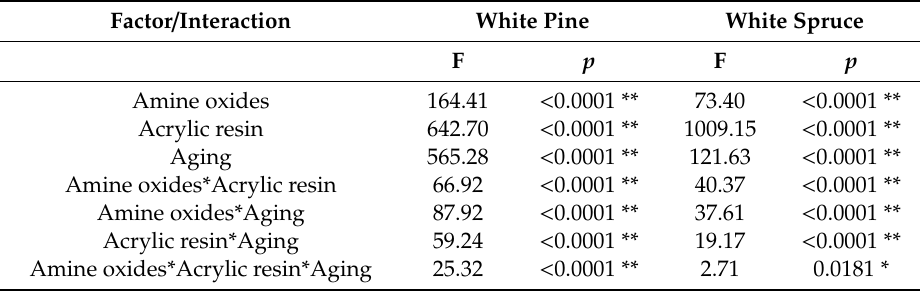
Amine oxides*Acrylic resin*Aging 25.32 * = p < 0.05, ** = p <